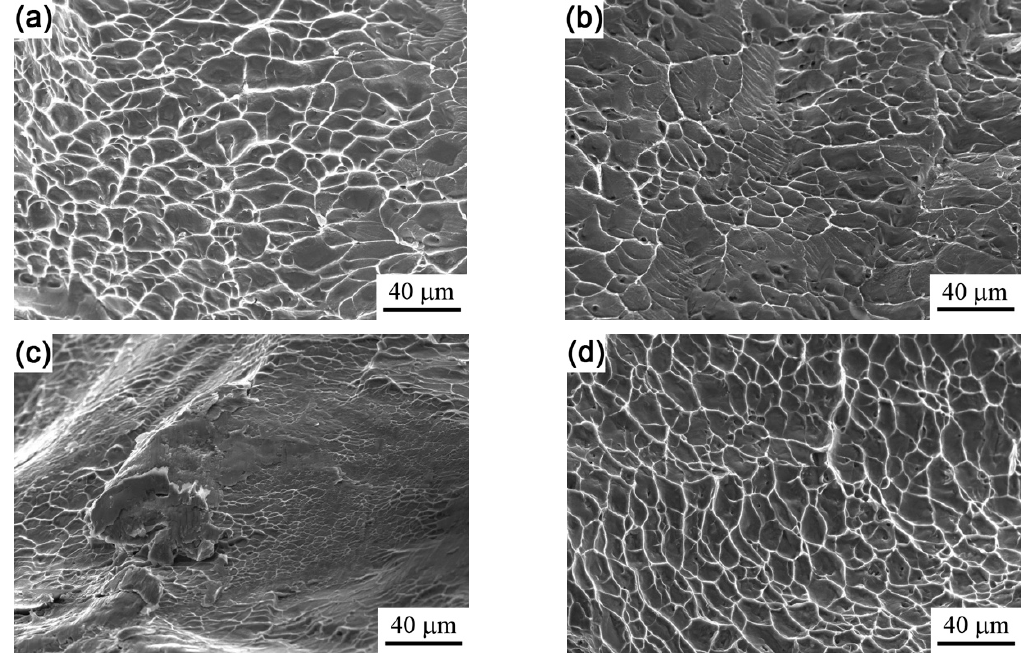
Figure 7. Cross-sectional fractographies of the alloy treated by different charging voltages: 2 kV ( a ), 4 kV ( b ), 6 kV ( c ), and 8 kV ( d